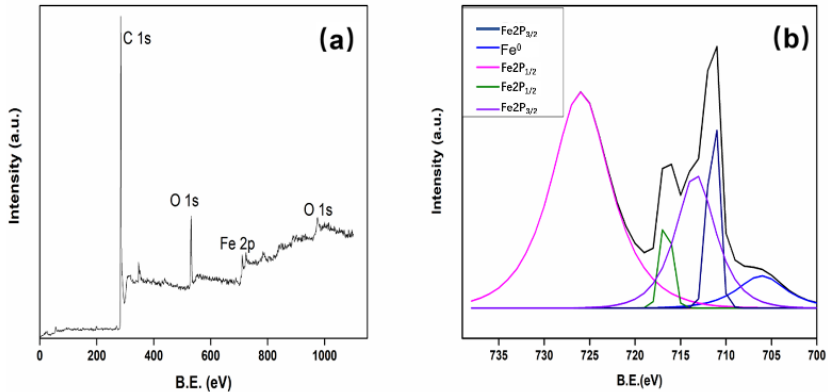
Figure 7. XPS spectrum ( a ) and deconvoluted Fe 2p spectrum ( b ) of Fe/CA.